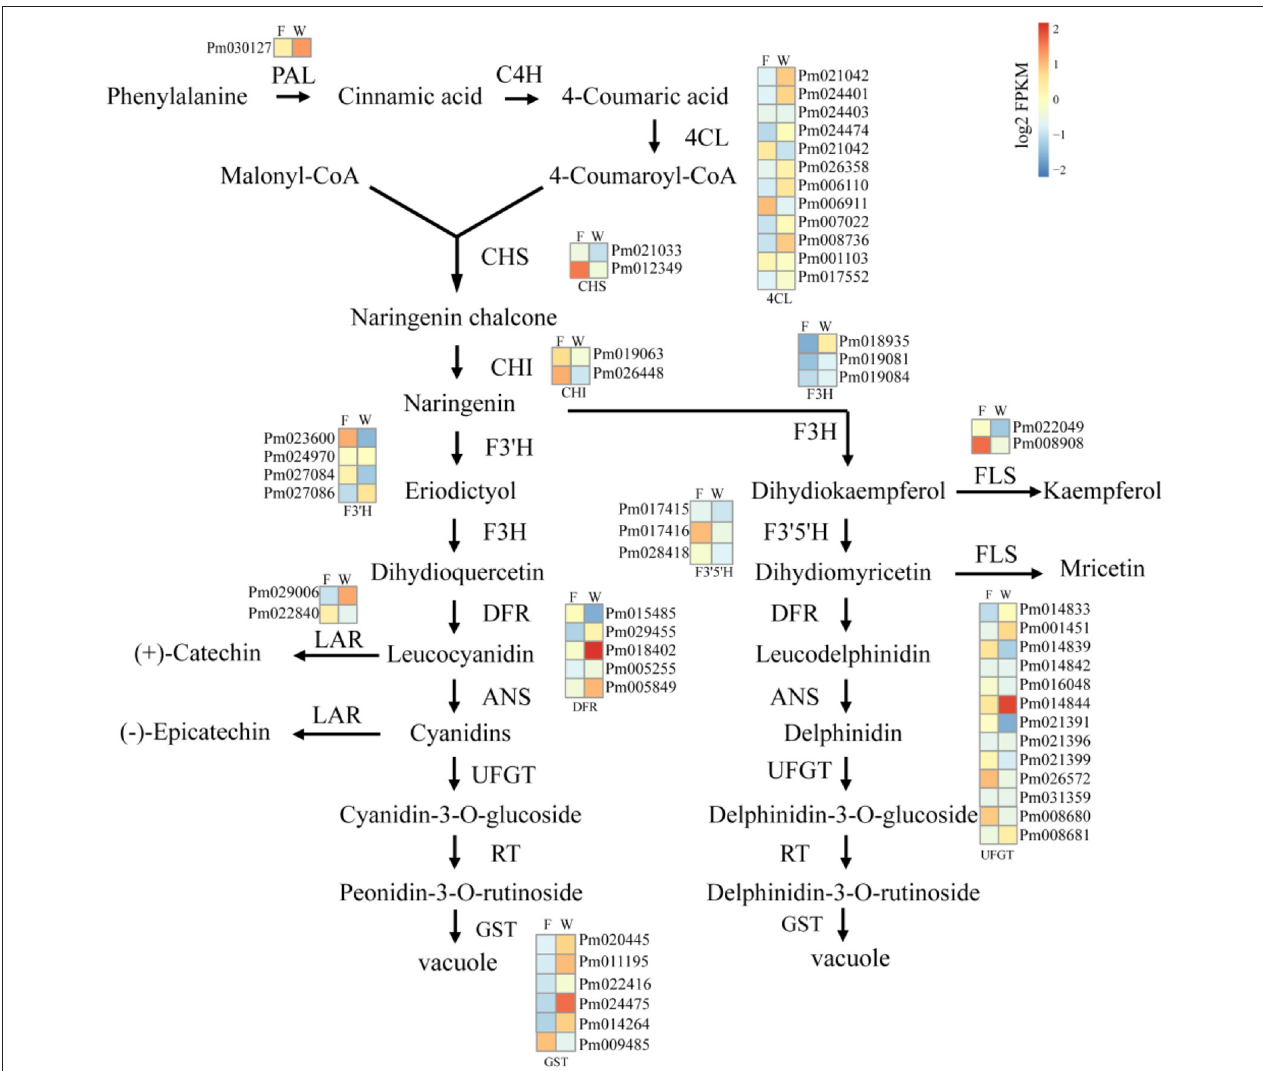
FIGURE 4 | The analysis of unigenes involved in anthocyanin biosynthesis of WYY. Phenylalanine ammonia-lyase (PAL), cinnamic acid 4-hydroxylase (C4H), 4 coumarate-CoA ligase (4CL), chalcone synthase (CHS), chalcone isomerase (CHI), flavanone 3-hydroxylase (F3H), flavonol synthase (FLS), anthocyanidin 3-O-glucosyltransferase (UFGT), Dihydroflavonol 4-reductase (DFR), anthocyanidin reductase (ANR), leucoanthocyanidin dioxygenase (LAR). F:FLE, W:WYY. Squares represent different transcripts of genes. In the heat maps, blue-yellow-red scale represent low and high transcript expression,